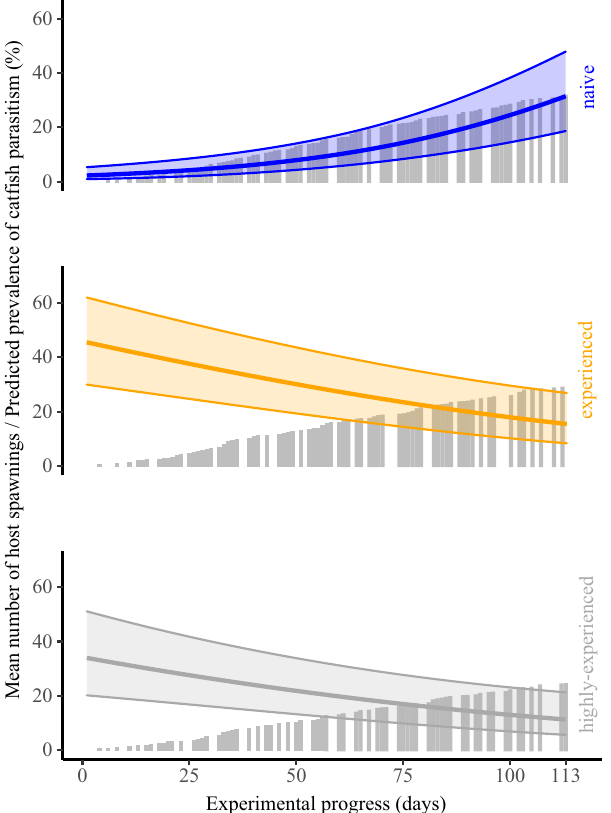
Fig. 2 Relationship between the prevalence of brood parasitism by naïve cuckoo cat fi sh and the number of host spawnings they witnessed. Grey bars represent treatment-speci fi c cumulative sums of host spawnings. The lines represent predicted probability of successful parasitism by cuckoo cat fi sh for naïve (blue), experienced (orange), and highly experienced (grey) cat fi sh based on a logistic GLMM (solid lines) and predicted standard errors for the predicted values (shaded areas). Source data are provided as a Source Data fi le.